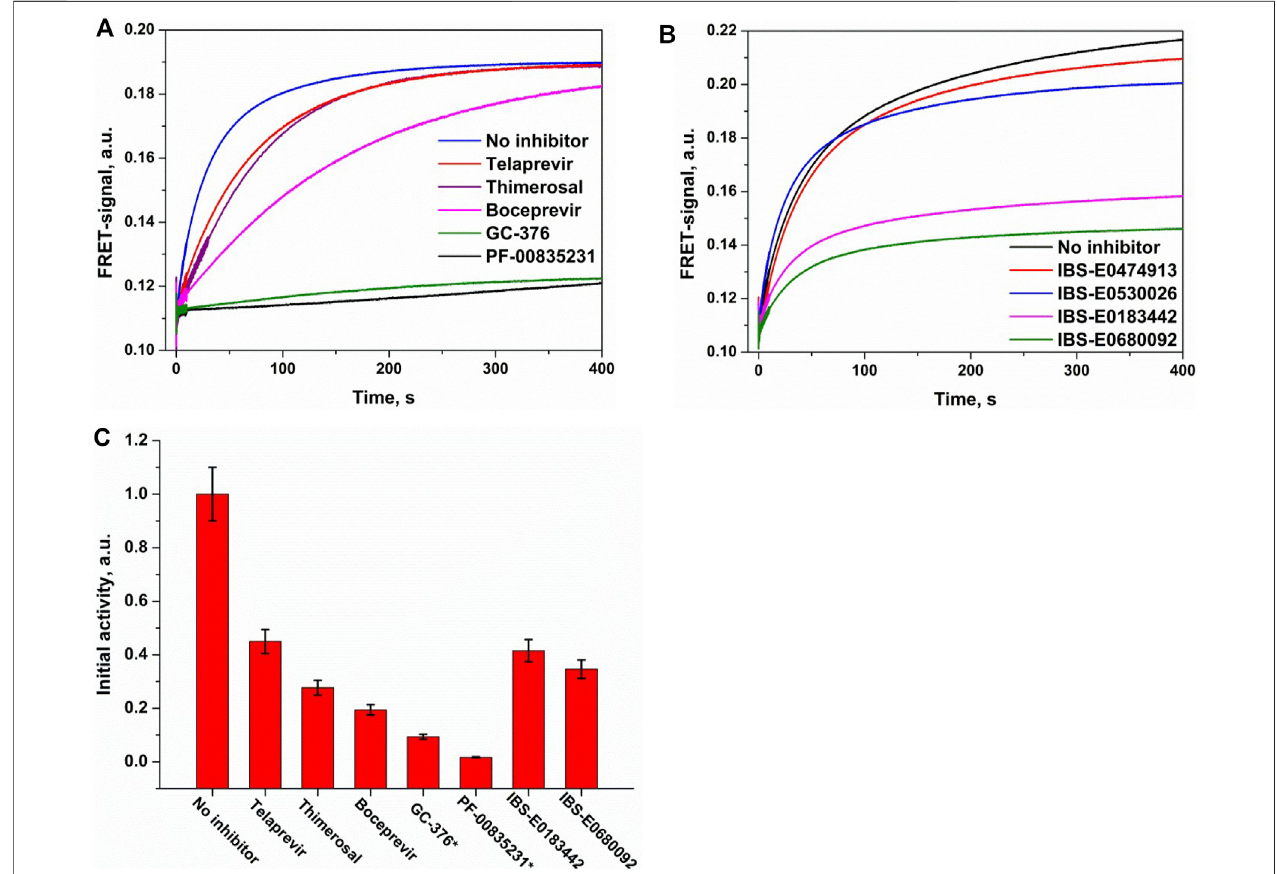
FIGURE9| ComparativeanalysisofM pro inhibition bycovalent (A) andnoncovalent (B) inhibitors. (C) Residualenzymaticactivity calculatedfromtheinitialslopeof kineticcurves.Theactivityoffreeenzymewasnormalizedto1.0.FRET-Sandenzymeconcentrationswere2.5 µM,andtheinhibitorconcentrationwas25 µMexceptfor the compounds marked with an asterisk (2.5